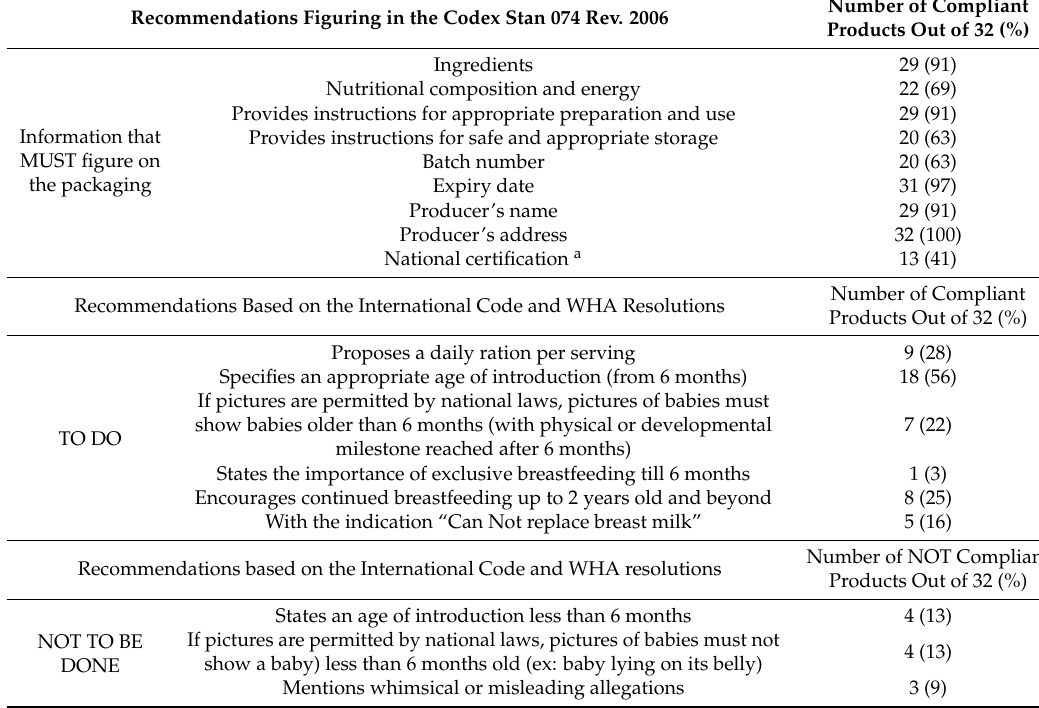
Table 4. Criteria used to evaluate the adequacy of the labelling of PCBBs marketed as complementary foods for 6–23 month-old